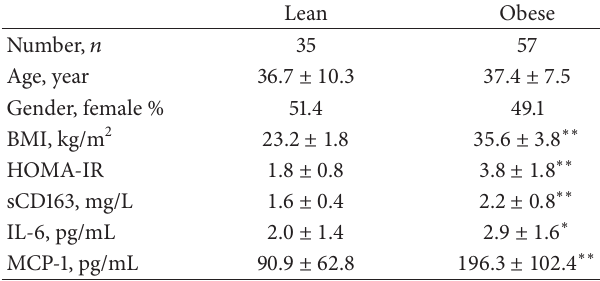
Table 2: Characteristics of lean and obese